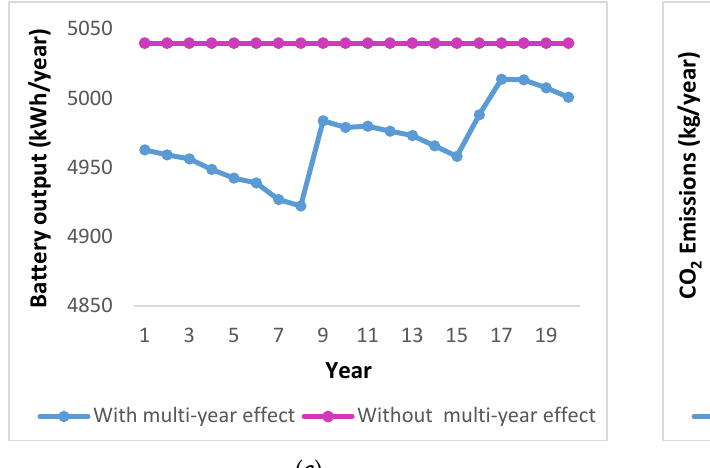
Figure 12. Year–year analysis for ( a ) PV production; ( b ) Grid purchases; ( c ) Battery output energy; ( d ) CO 2 emissions, using CC strategy.